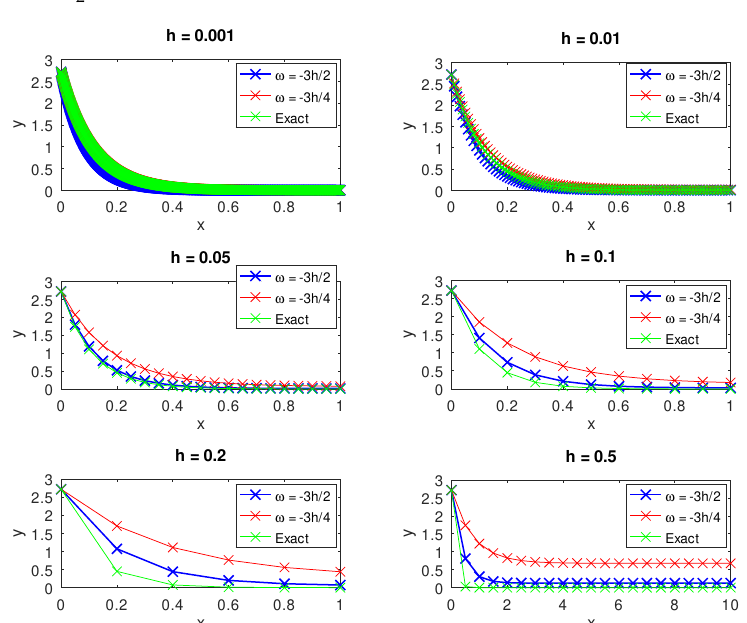
3 h , using New- 2 3 h − using Newton’s 2 − 3 h by solving an under-determined 2 −